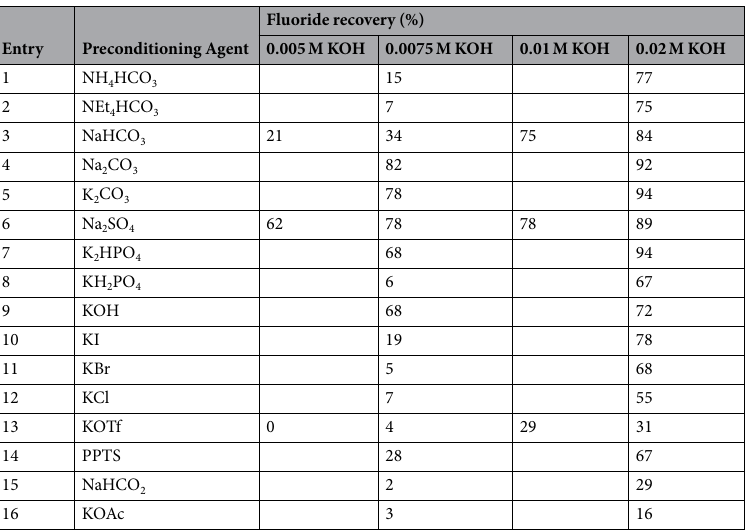
Table 1. Investigation of the effect of pre-conditioning agent on the elution of [ 18 F]fluoride from Waters QMA- lite